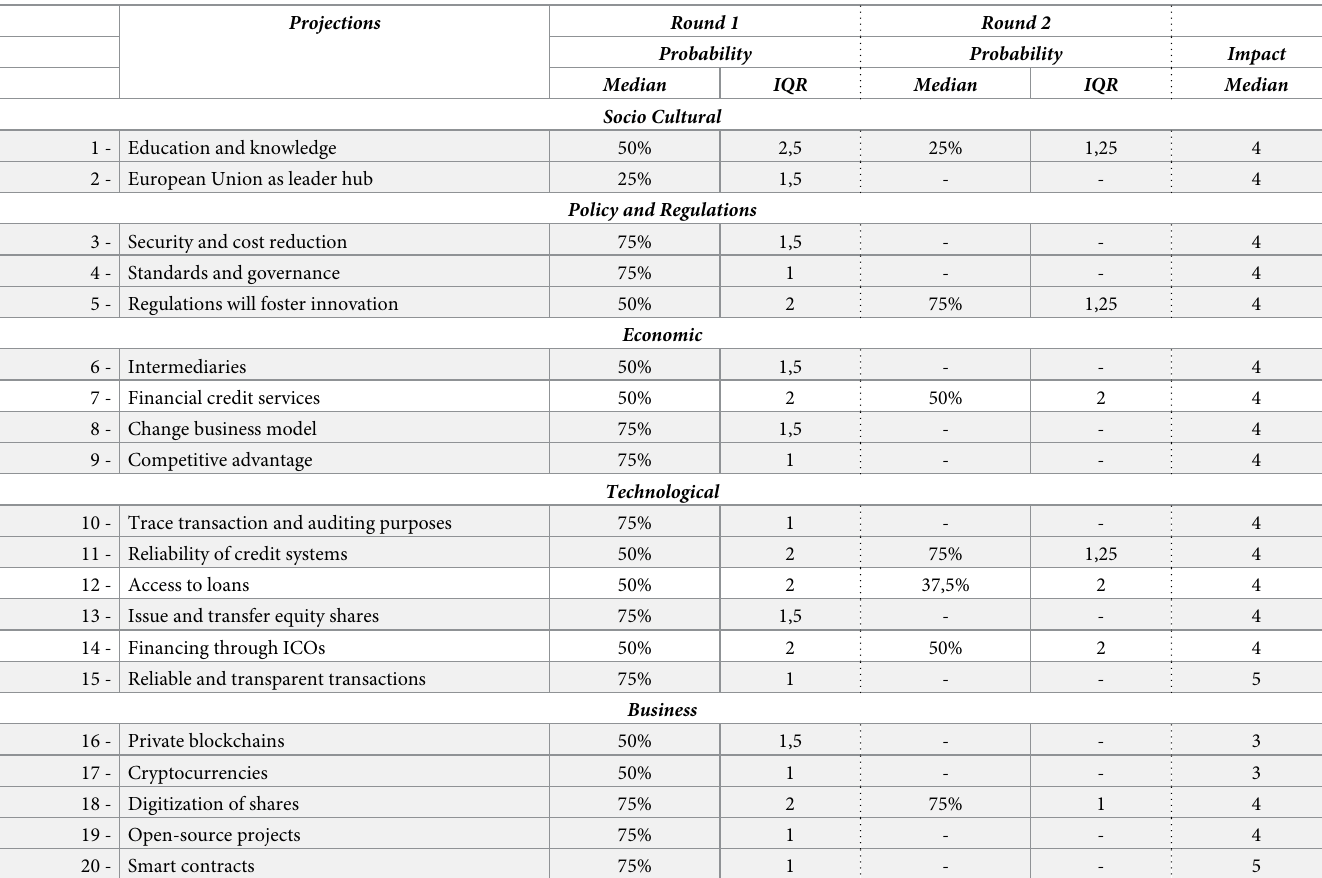
Table 5. Quantitative data obtained during the two rounds of